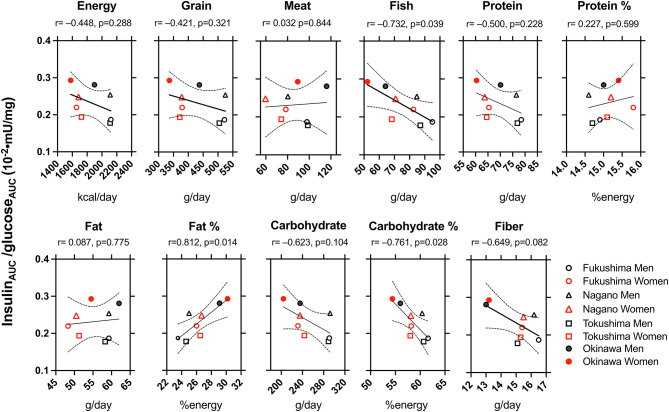
The correlation between the indices of dietary factors and indices of insulin secretion and sensitivity in Fukushima men (°) and women (°), Nagano men (Δ) and women (Δ), Tokushima men (□) and women (□), and Okinawa men (•) and women (•). r: The Pearson product correlation coefficient and p: probability. Solid and dotted lines indicate r with 95% confidential intervals.